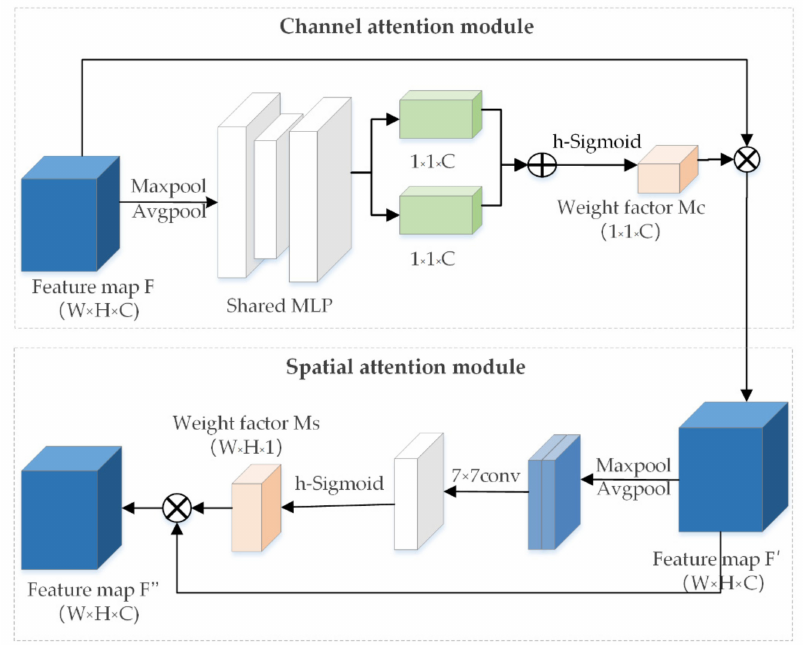
Figure 6. The CBAM module structure presented in this